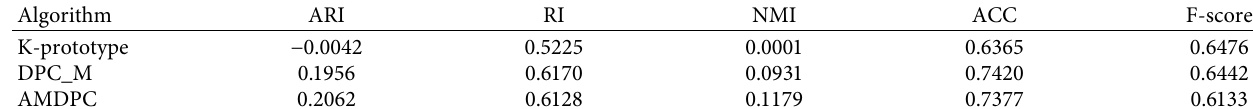
Table 8: Clustering results of the Adult dataset.